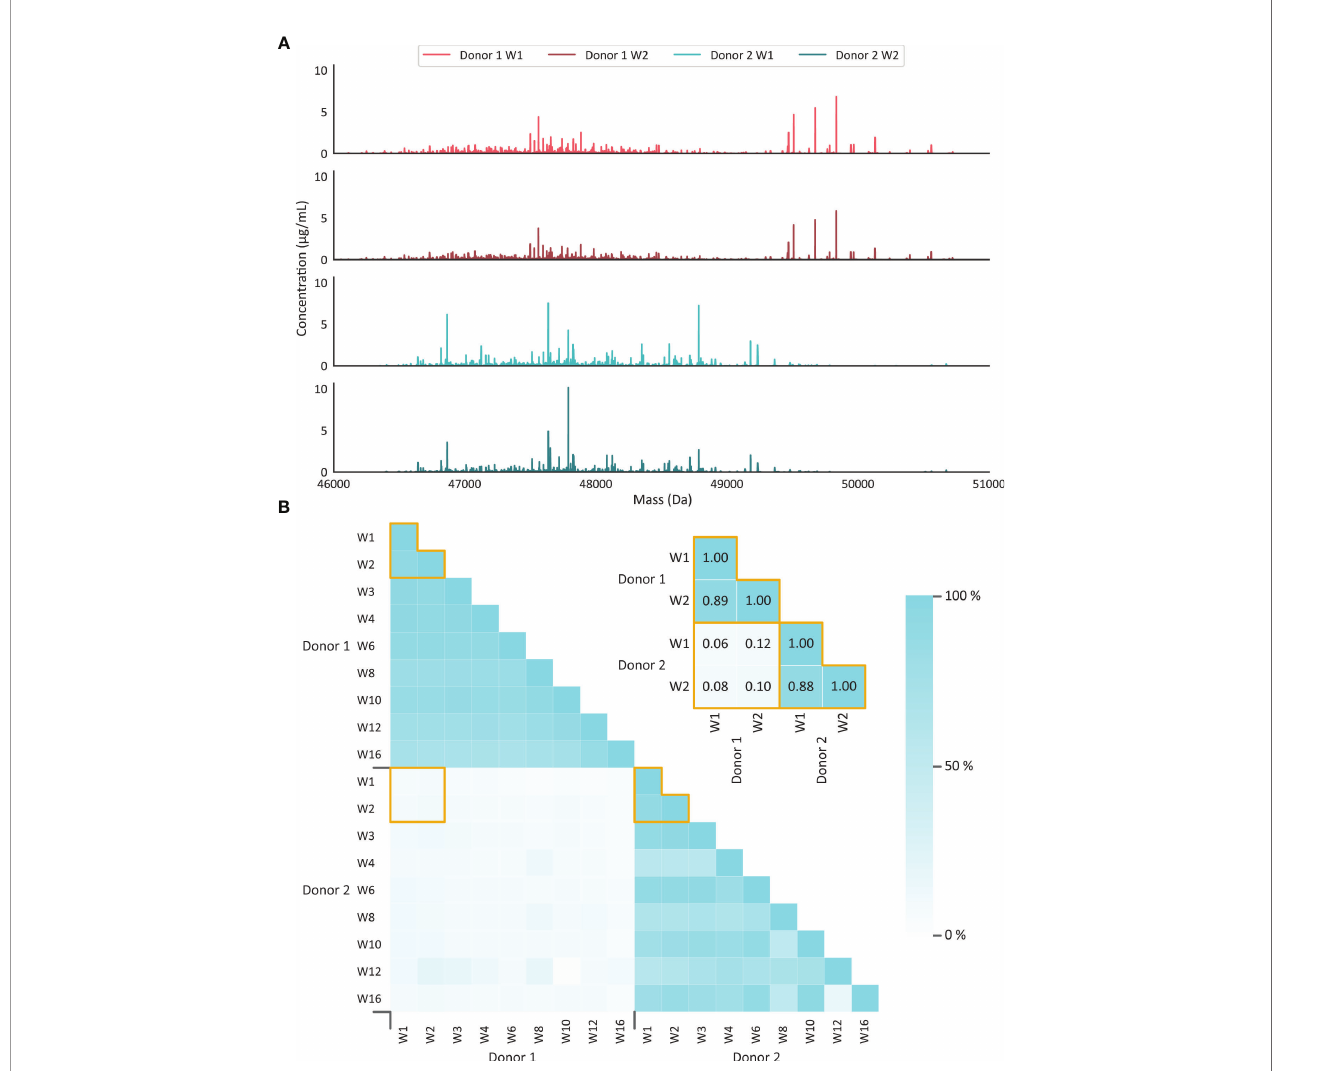
FIGURE 4 | Human milk sIgA1 clonal pro fi les are stable over time, and highly unique for every donor. (A) Illustrative deconvoluted Fab mass pro fi les with the top two originating from donor 1 with milk obtained at weeks 1 and 2, and the bottom two originating from donor 2 with milk obtained at weeks 1 and 2. Each peak represents a unique Fab (based on unique RT/mass pair) and the peak height represents the concentration of that clone in the milk. The sIgA1 pro fi les obtained at all other time points are provided in Supplemental Figure S5 . Clearly, just a limited number of distinct clones dominate the sIgA1 repertoire in each of the two donors. (B) Observed overlap in clonal sIgA1 repertoires within and in between donors. The persistence of repertoires is given as a percentage of the total sIgA1 clone abundance. Each small square depicts a percentage, as indicated by the color bar, of overlap between the samples. The inset depicts a zoom-in of the data for the pro fi les shown in (A) , annotated with the overlap values. The overlap in the sIgA1 repertoire is ~80% when comparing samples of the same donor, even when samples were collected as much as 16 weeks apart. Between donors hardly any overlap in the repertoires is observed (below ~10%), whereby even each clone seems to be uniquely detected in just one of the